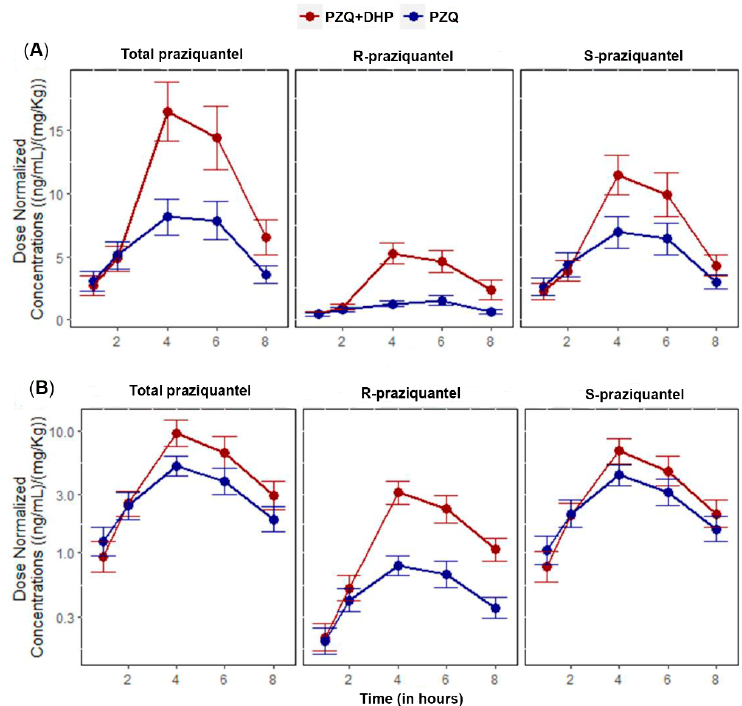
Figure 1. Comparisons of mean of dose-normalized concentration-time profiles of total PZQ, R-PZQ and S-PZQ between PZQ versus PZQ + DHP treatment arms. Error bars represent standard errors of the mean (SEM). ( A ) Linear/linear scale ( B ) Log/linear scale.